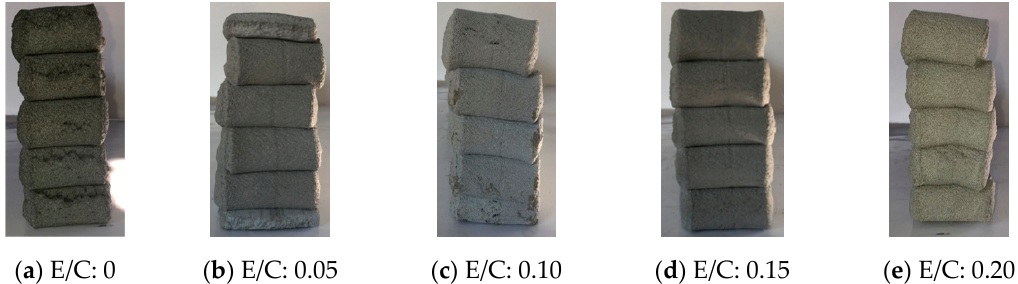
Figure 4. Results of the buildability test at a 65% flow and different ethylene-vinyl acetate (EVA)/cement ratios [15].